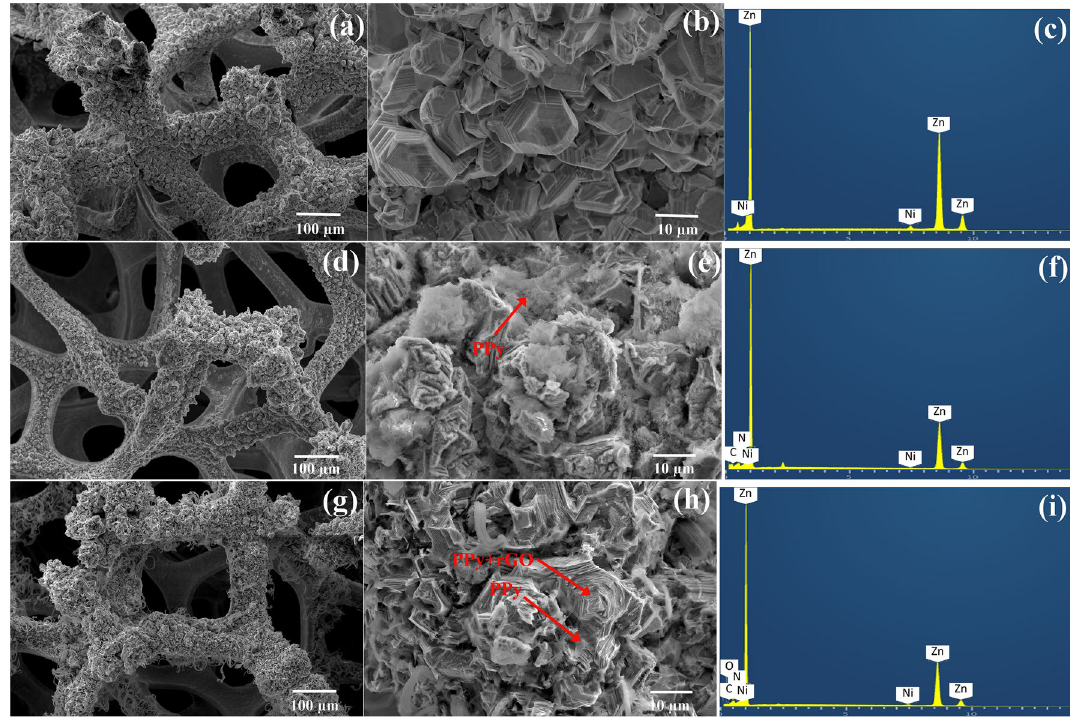
Figure 3. Low, high magnification FESEM images and corresponding element mappings of ( a – c ) Zn, ( d – f ) Zn-PPy, and ( g – i )